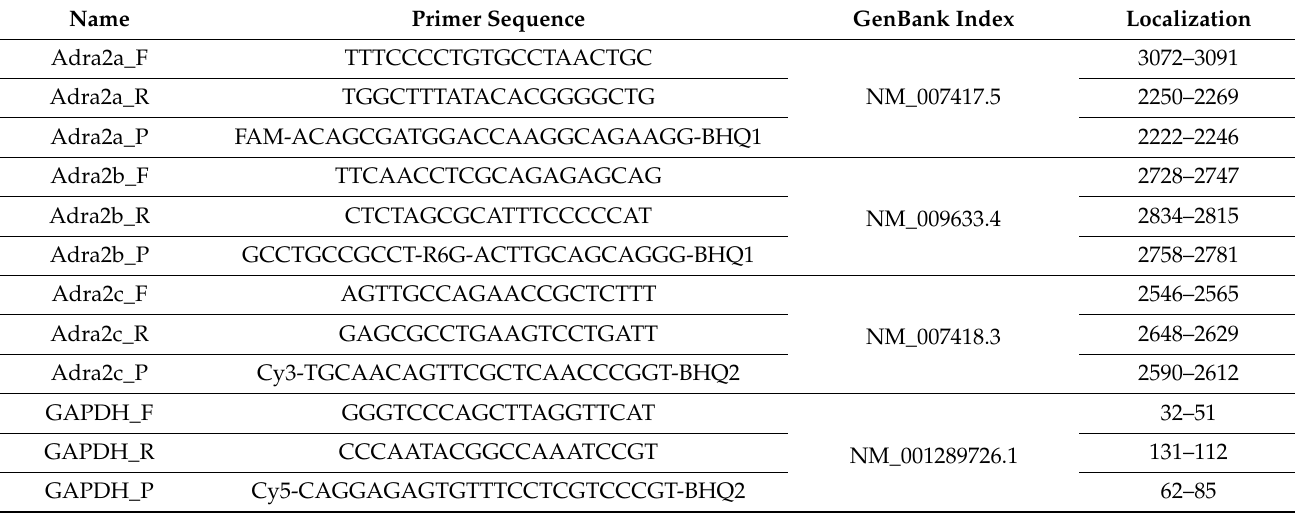
Table 1. Primers for RT-qPCR